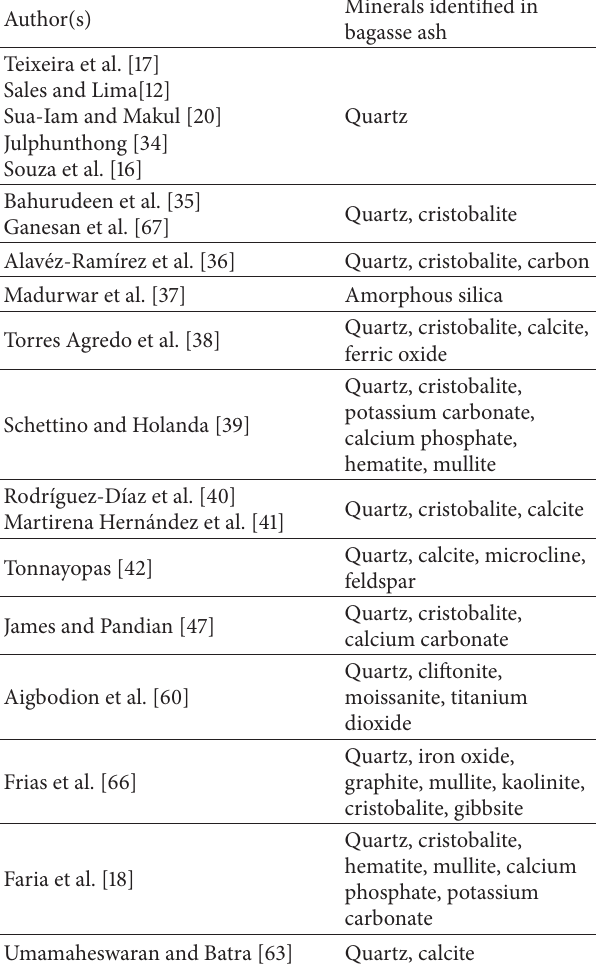
Table 3: Minerals present in bagasse